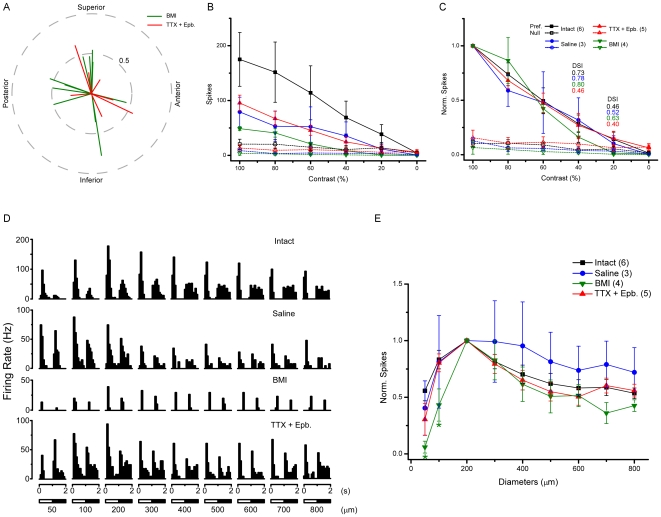
Homeostatic properties of DSGCs in BMI and Epb plus TTX treated retinas.A: DSGCs with preferred direction falling into all four subtypes were observed. The length of the lines represents normalized response magnitude (vector sum divided by total number of spikes), the angle preferred direction. B: Clear directional responses to square wave gratings with contrast as low as 20%, normalized data are shown in C (numbers in corresponding color represent DSI of treated DSGCs). D: Responses to a stationary flashing spot of different size. Although cells in treated retina generally exhibit lower firing rate, clear center-surround interaction can be seen especially in normalized data in E. Black: Intact; Blue: Saline; Green: BMI; Red: Epb+TTX. Numbers in parentheses indicate the cell number.